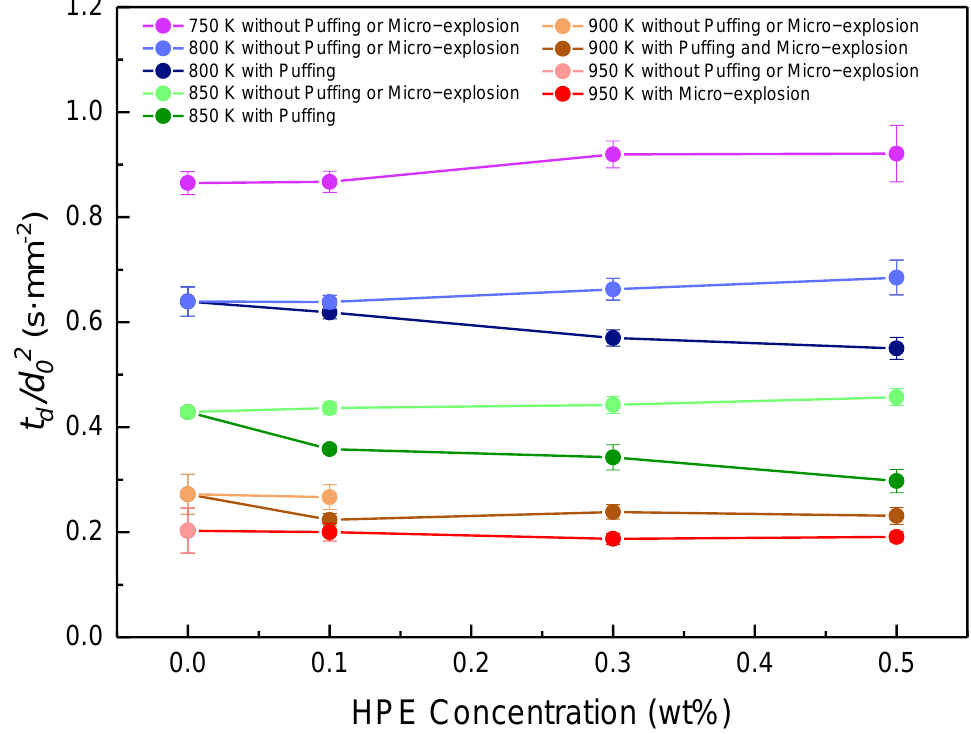
Figure 11. Variation in droplet lifetime with HPE concentration at temperatures of 750–950 K. Error bars show the standard deviation.